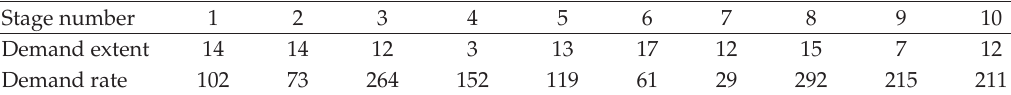
Figure 3: Example of mutation operating. Table 1: Demand data in Problem